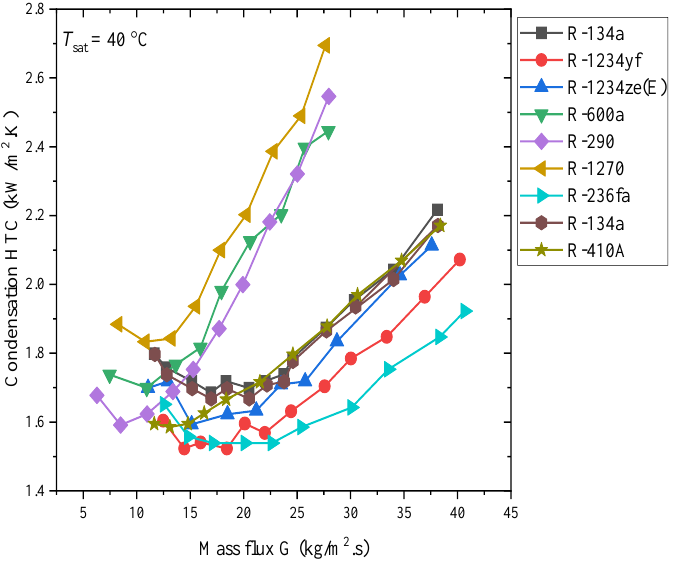
slightly higher than that of R-134a while the pressure drop is similar for both refrigerants under the same working conditions.